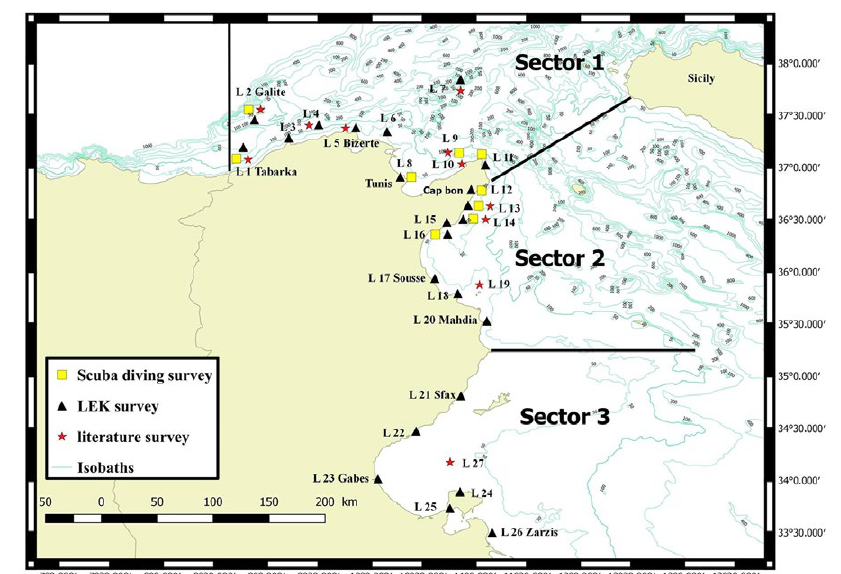
Fig. 1. – Sectors and localities along Tunisian marine waters and source of information to obtain distribution data on gorgonian species records.